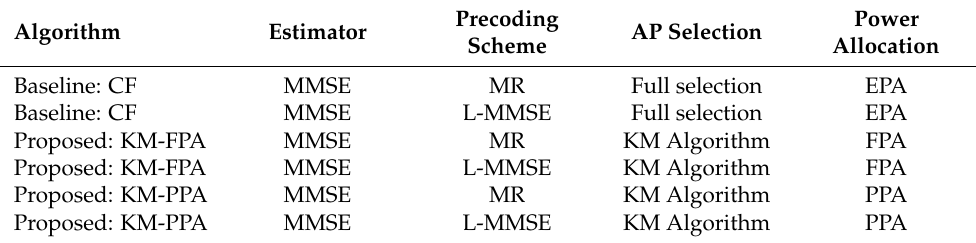
5.2.1. Baseline Algorithm: Traditional Cell-Free Massive MIMO Systems with Distributed Operation